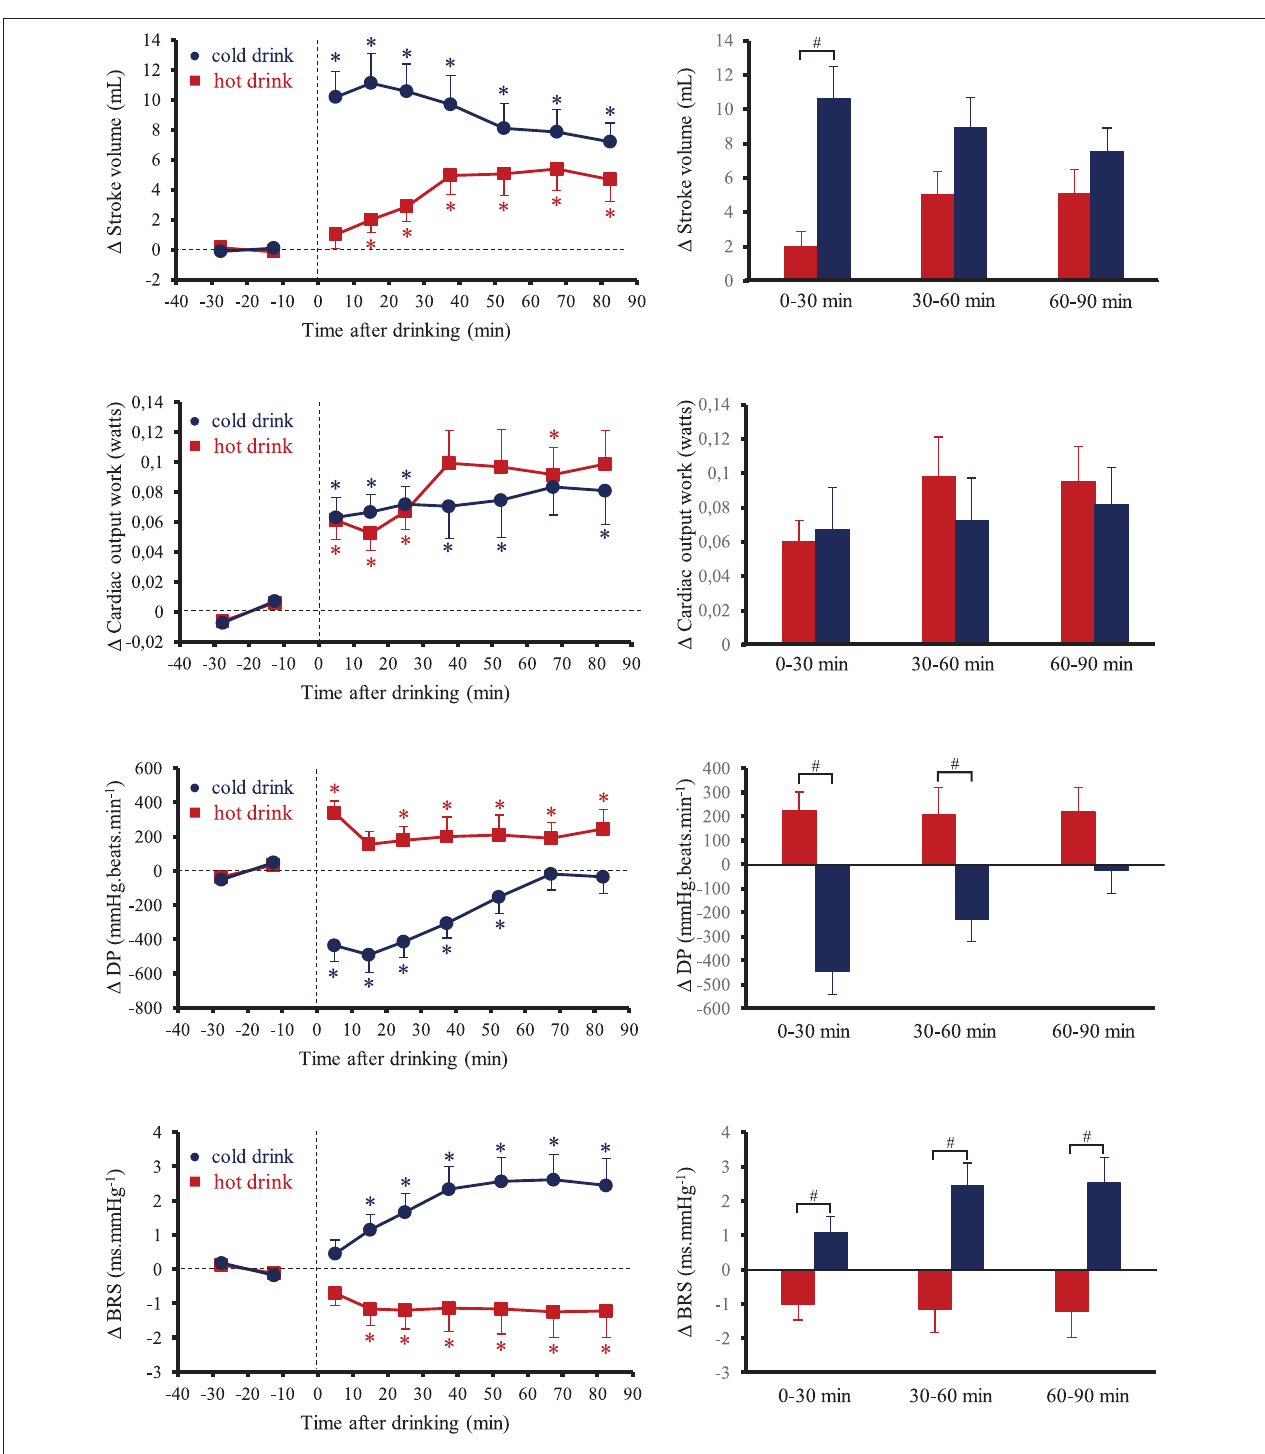
FIGURE 2 | (Left) Time course of the changes in stroke volume, cardiac output work, double product (DP) and baroreflex sensitivity (BRS). (Right) Mean responses averaged over 0–30, 30–60, and 60–90min relative to baseline values and presented as a delta (i.e., average over 0–30, 30–60, and 60–90min post-drink period, respectively, minus the average over the 30-min baseline period). Drinks: hot tea ( (cid:4) and ); cold tea ( (cid:8) and ). * p < 0.05 significant differences over time from baseline values; # p < 0.05 significant differences between responses to the